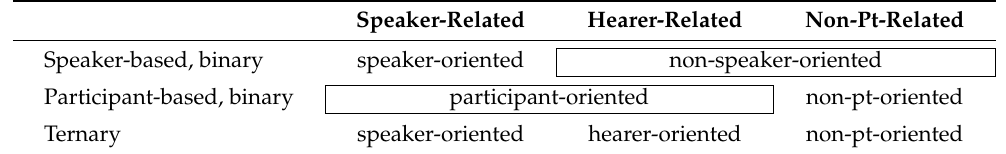
Table 1. Demonstrative